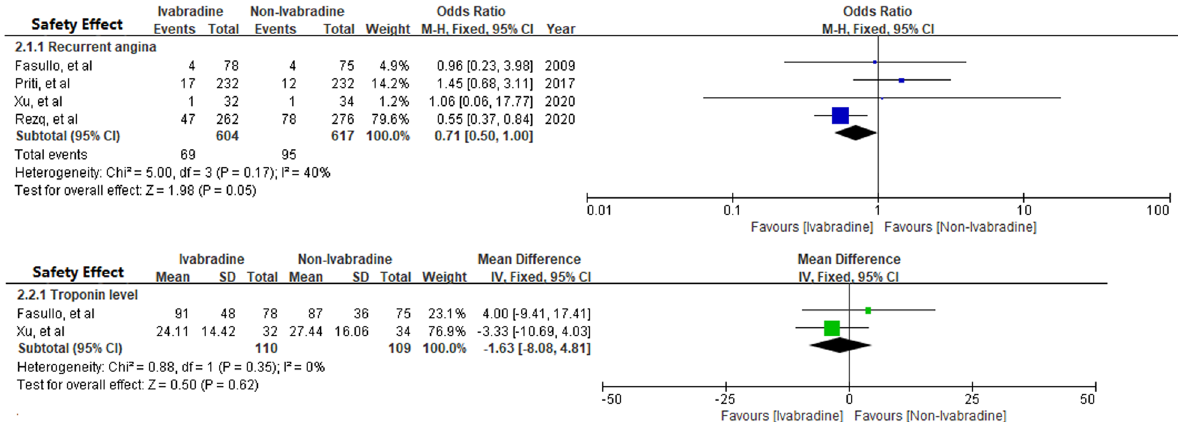
Fig. 7 The safety effect of Ivabradine